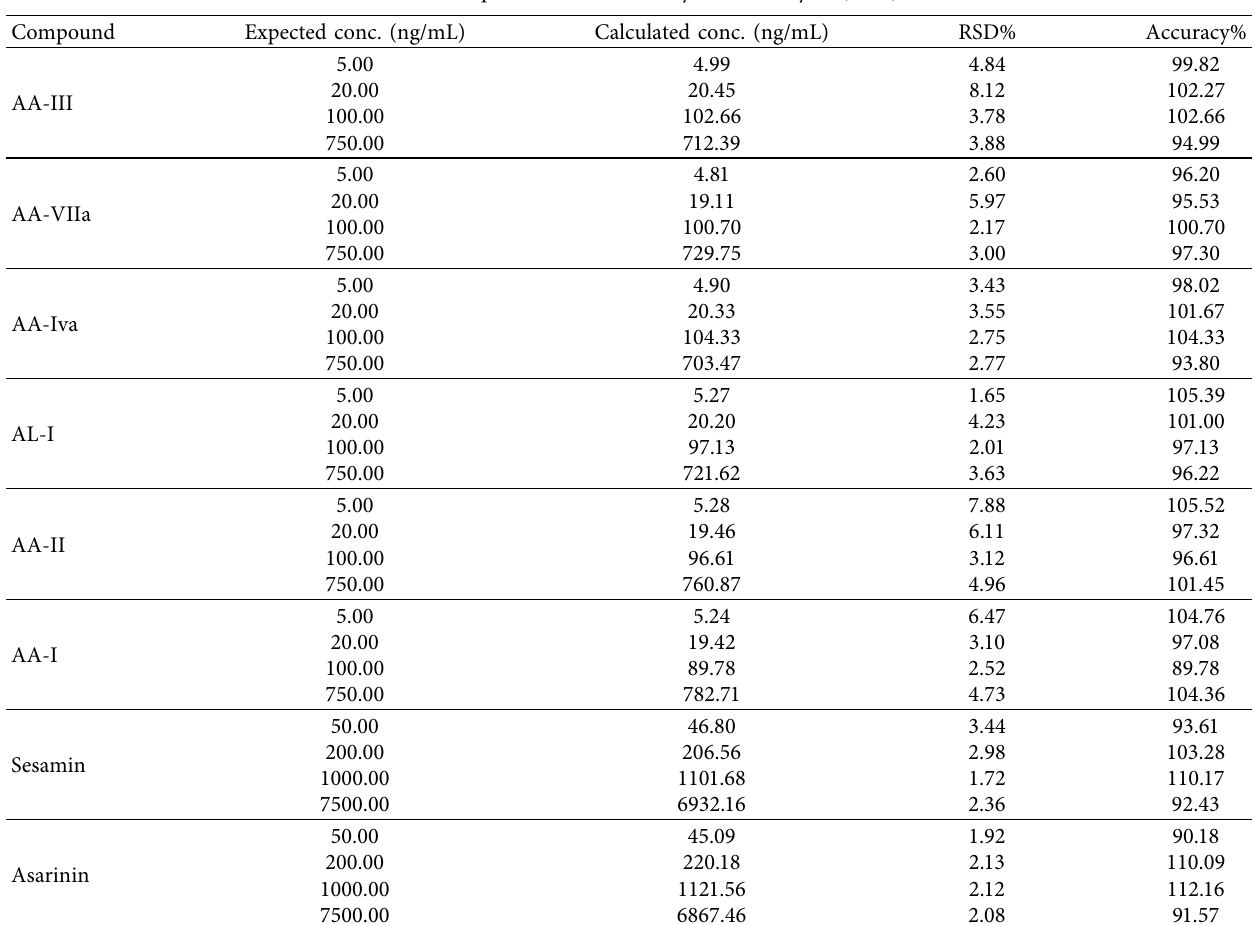
Table 4: The precision and accuracy of the analytes ( n � 6).